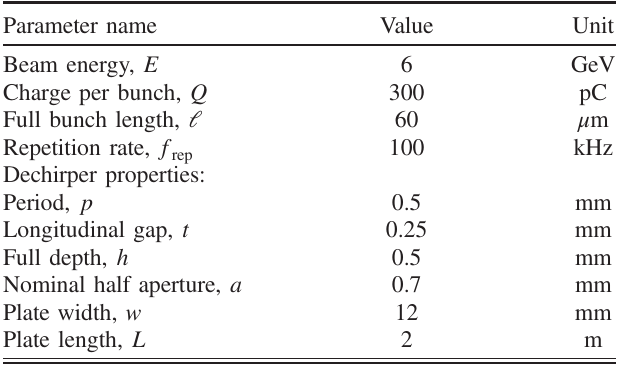
TABLE I. Selected beam and machine properties for LCLS-II used in example calculations. This is the high charge option with its maximum repetition rate. The charge distribution is assumed to be uniform with peak current I ¼ 1 . 5 kA. The dechirper properties are those of the RadiaBeam/LSLAC dechirper, which consists of two modules, each with corrugated plates of length L ¼ 2 m. The plates are made of aluminum; we take conductivity σ ¼ 3 . 2 × 10 17 = c